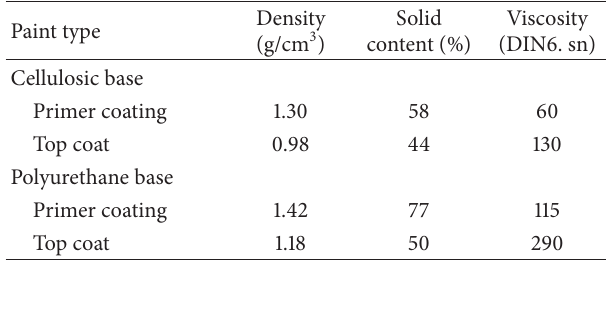
Table 1: Specifications of the finishing materials used for the exper- iments.